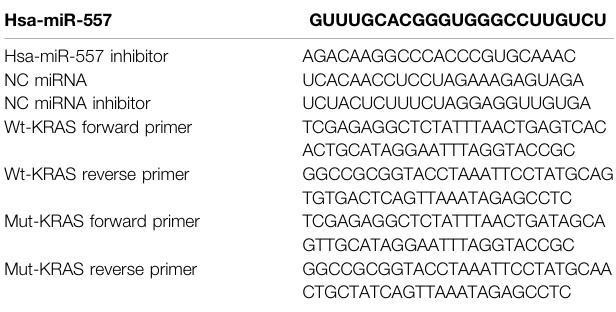
TABLE 2 | Sequences used in plasmid